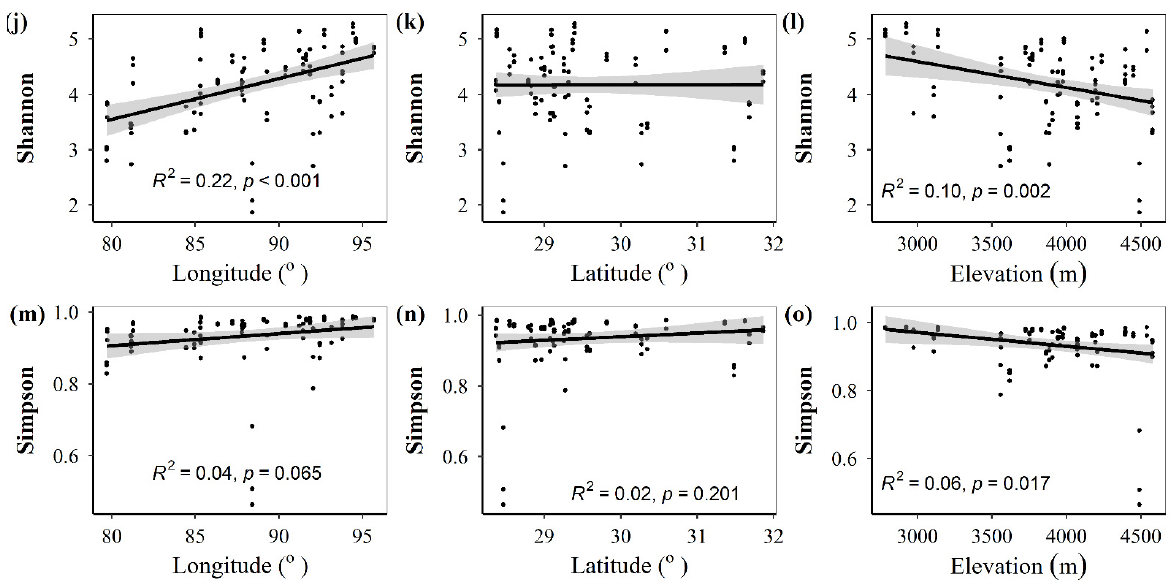
Figure A12. Relationships between species α -diversity and geographic variables (longitude, latitude, and elevation) at 10–20 cm depth. ( a – c ) species richness (SR), ( d – f ) Chao1, ( g – i ) ACE, ( j – l ) Shannon, and ( m – o ) Simpson.